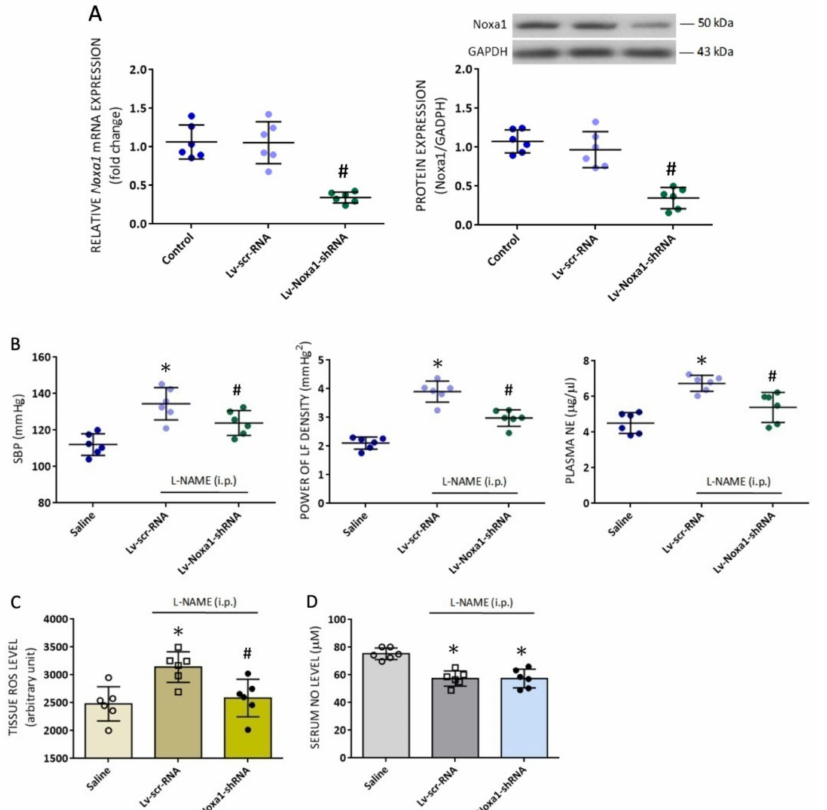
Figure 8. Effect of manipulations of Noxa1 gene in RVLM on mRNA and protein expression, and changes in cardiovascular responses and levels of ROS in RVLM and serum NO of adult rats induced by systemic L -NAME treatment: ( A ) Changes in mRNA transcription of Noxa1 and representative gels (insets) and densitometric analysis of results from Western blot showing changes in protein expression of Noxa1 in RVLM tissues 4 days after bilateral microinjection into RVLM of lentiviral vectors (Lv) containing short hairpin interfering RNA (shRNA) targeting the rat Noxa1 sequence (Lv-Noxa1-shRNA) or a scrambled (scr) control shRNA. ( B ) SBP, power density of the LF component of SBP signals, and plasma NE levels; and ( C ) tissue ROS and ( D ) serum NO levels, determined on day 14 after i.p. infusion of saline or L -NAME (10 mg/kg/day) in adult rats that received additional treatment with bilateral microinjection into RVLM of Lv-scr-RNA or Lv-Noxa1-shRNA on day 10 after L -NAME treatment. Data on mRNA transcription and protein expression are normalized to the respective saline control value, which is set to 1.0. Data are presented as mean ± SD, n = 6 per group. * p < 0.05 versus corresponding saline-treated groups, and # p < 0.05 versus Lv-scr-RNA-treated groups in unpaired Student’s t